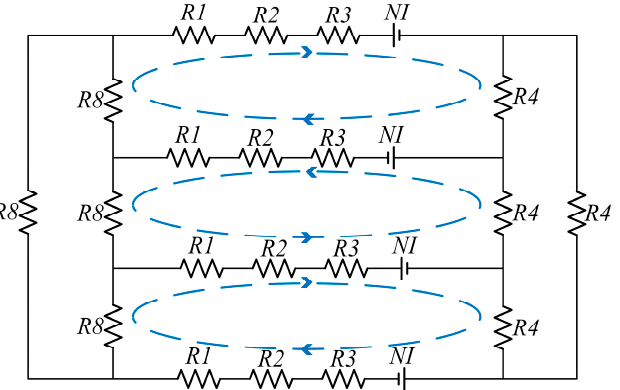
Figure 11. Circumferential configuration equivalent magnetic circuit model.